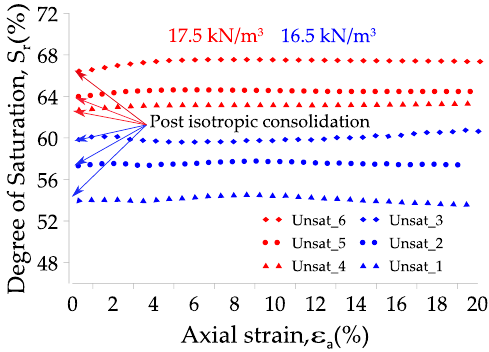
Figure 15. Behavior of the saturation at both densities in the shear phase.